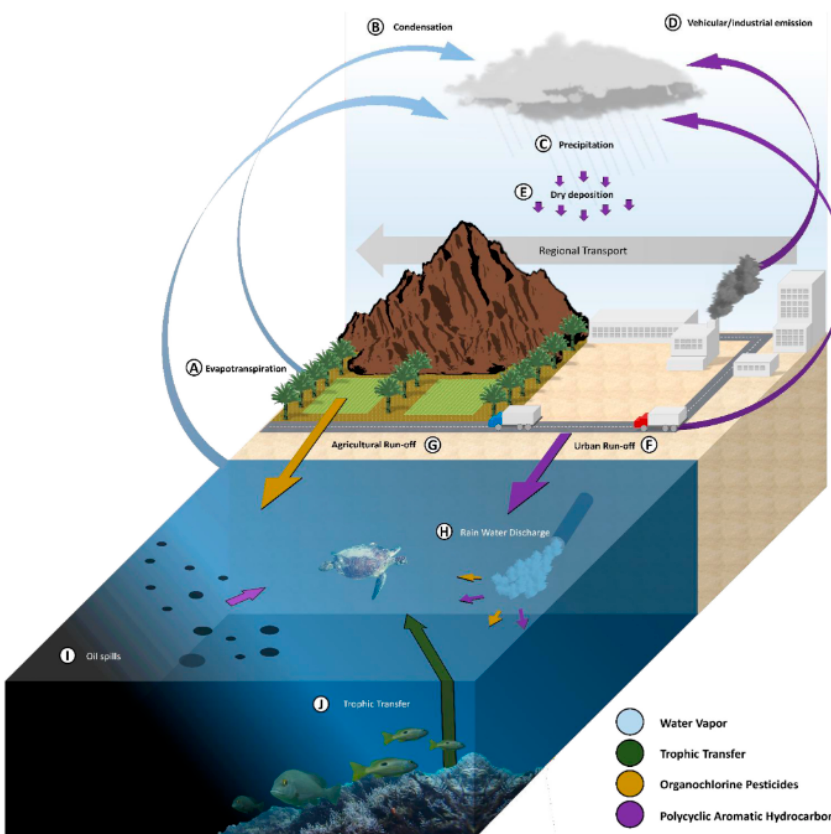
Figure 1. Main threats for sea turtles. Source [34].